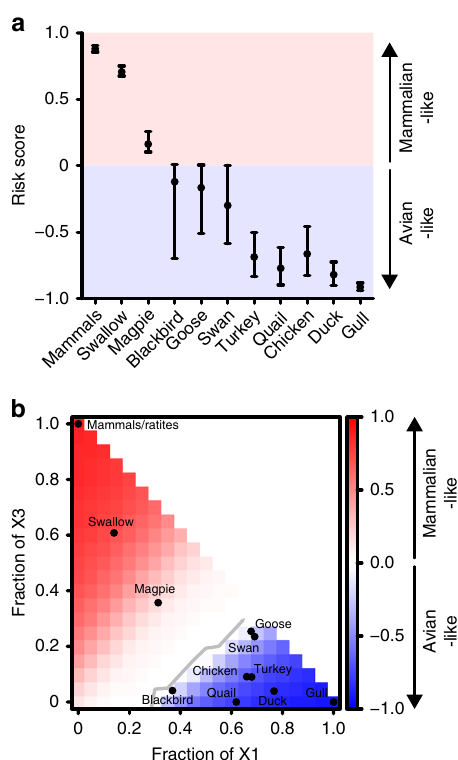
Fig. 6 Evaluating the risk of different species selecting for mammalian-like IAV adaptations. a Estimated relative risk scores for each indicated species to select for avian- or mammalian-like IAV vPol adaptations. The dots indicate the risk score prediction based on the best estimates of virus production rates alongside the 95% bootstrap con fi dence intervals (error bars). b Heat-map of risk scores based on the mathematical model and using the best estimates of virus production rates. Axes indicate fraction of the total ANP32A complement represented by X1 or X3, allowing threshold values for selection (gray line) to be